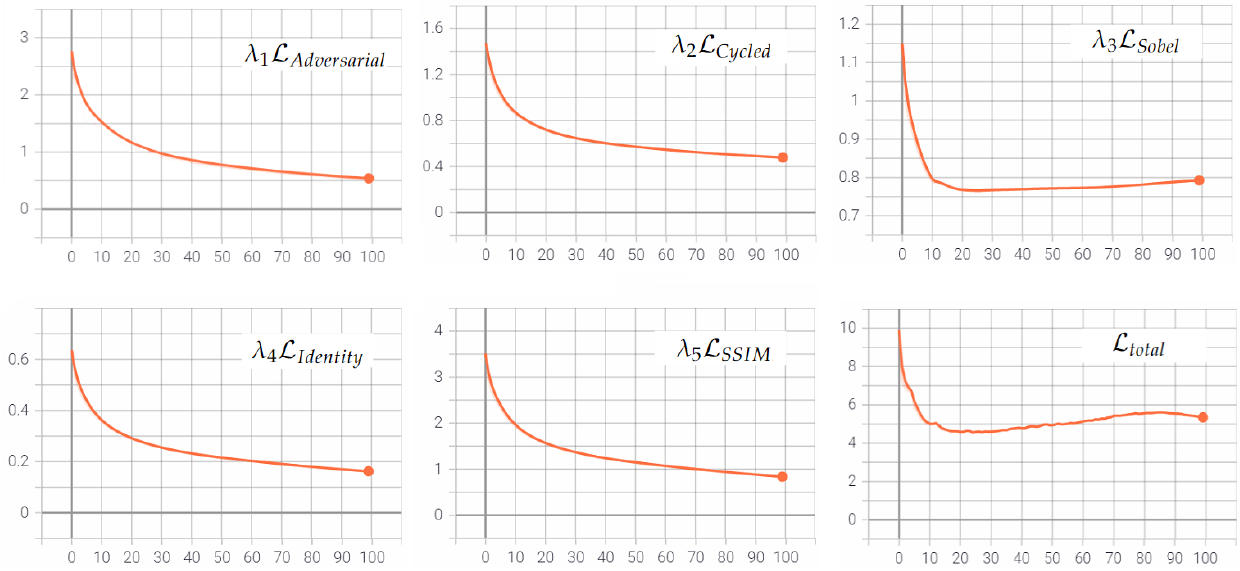
Figure 3. Adversarial, cycled, Sobel, identity, and SSIM losses from generator LR to HR and the total